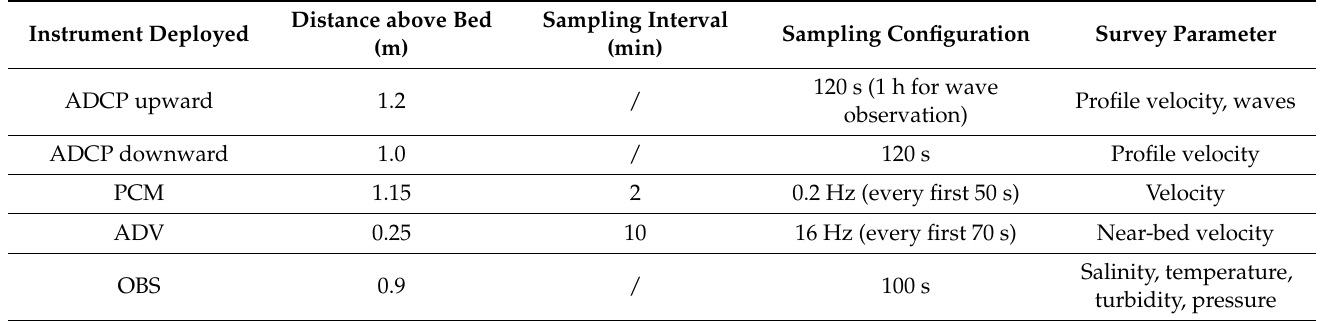
Table 1. Instruments mounted on the tripod and their sampling